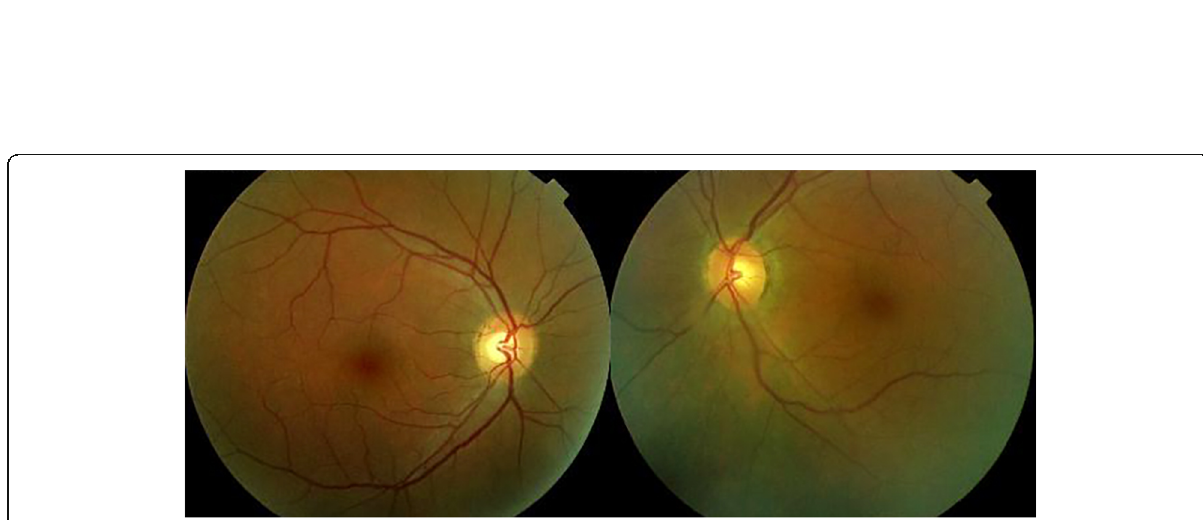
Fig. 5 a ICGA OD of VKH case 2 months after dual steroidal and non-steroidal immunosuppression. ICGA shows disappearance of HDDs and clear visualisation of normalized choroidal vessels. b ICGA OS of VKH case 2 months after dual steroidal and non-steroidal